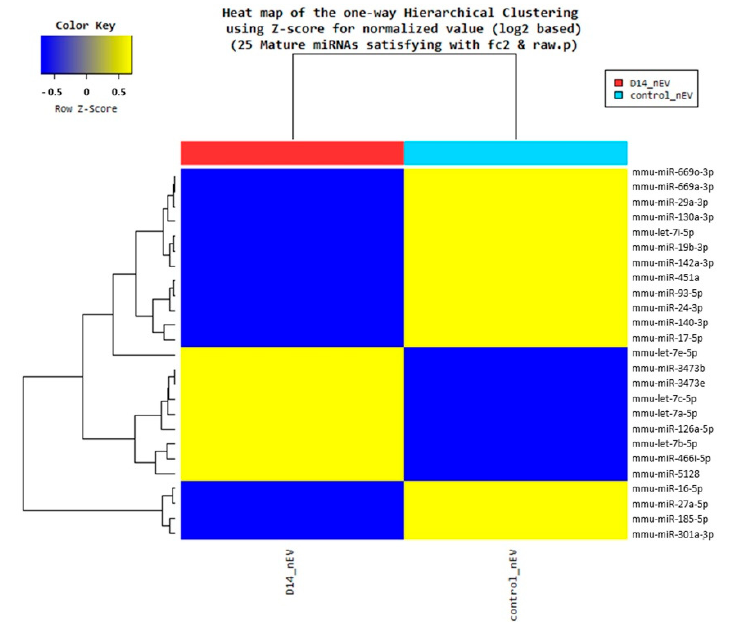
Figure 7. Heatmap of the differential microRNA (miRNA) expression in neuronal exosomes induced by atopic dermatitis. A total of 9 miRNAs were upregulated and 16 miRNAs were downregulated in the DNCB 14 days group compared to the control group.